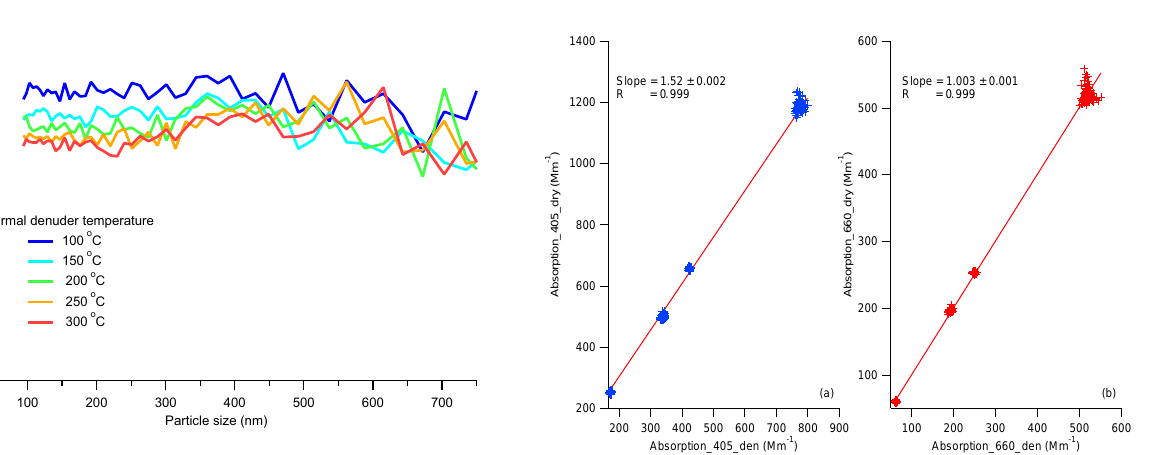
and denuded channels during thermal denuder bypasses for a day with significant differences in the 405nm channel. (a) 405nm, (b)